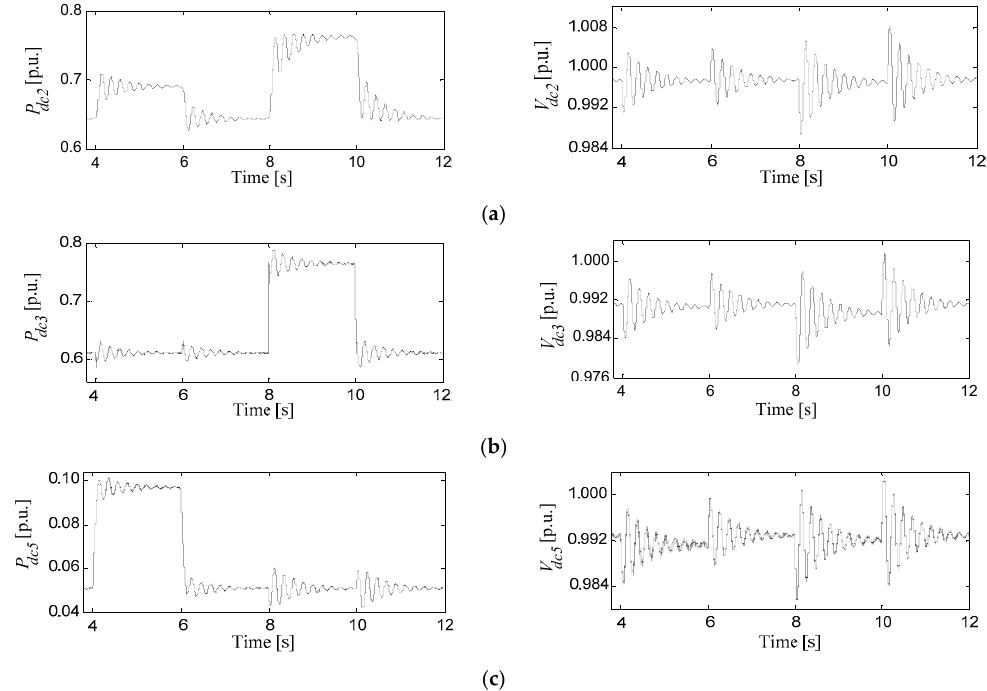
Figure 8. The uncompensated system response at different load-side disturbances according to Table 6; ( a ) VSC 2; ( b ) VSC 3; ( c ) DC/DC converter 5.